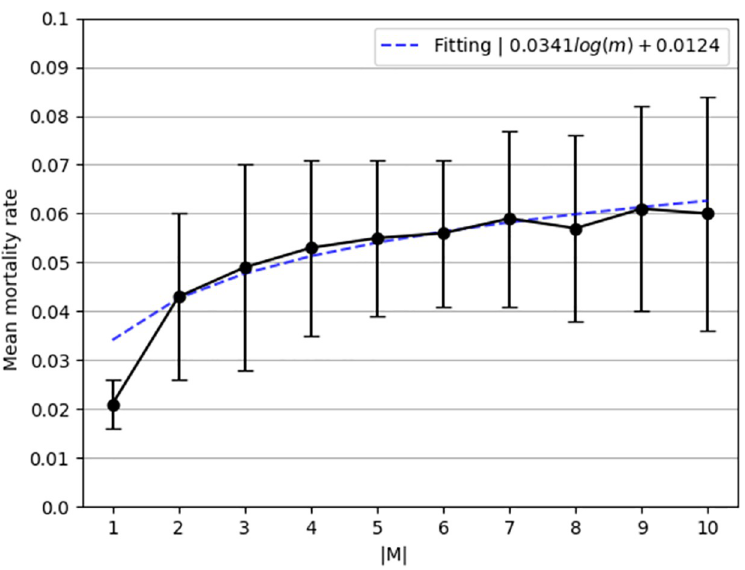
Fig 4. Mortality rate as function of the number of strains (| M |). The results are mean ± standard division for n = 1000